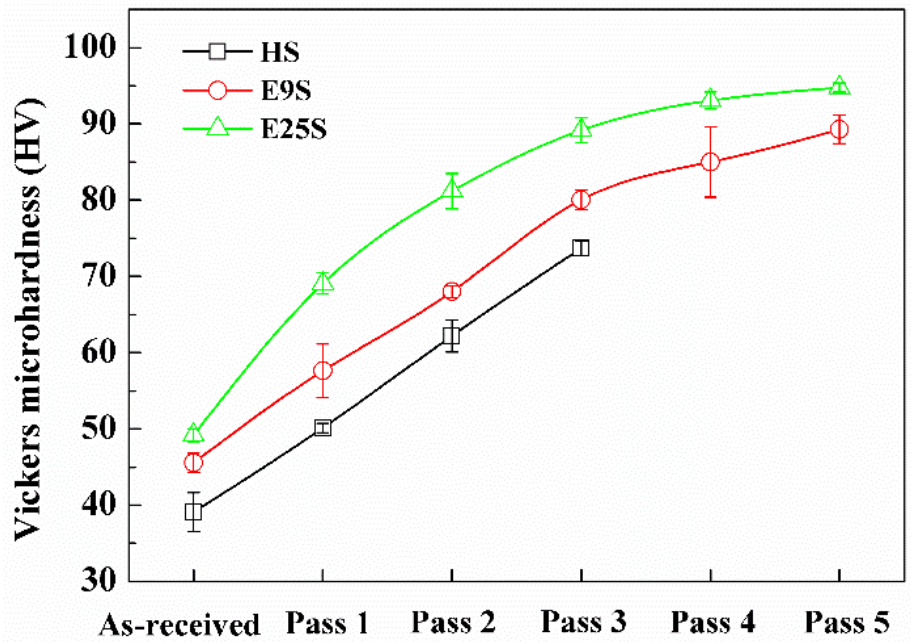
Figure 9. Variation in microhardness at the center of the alloy bars with the increase in the swaging pass.